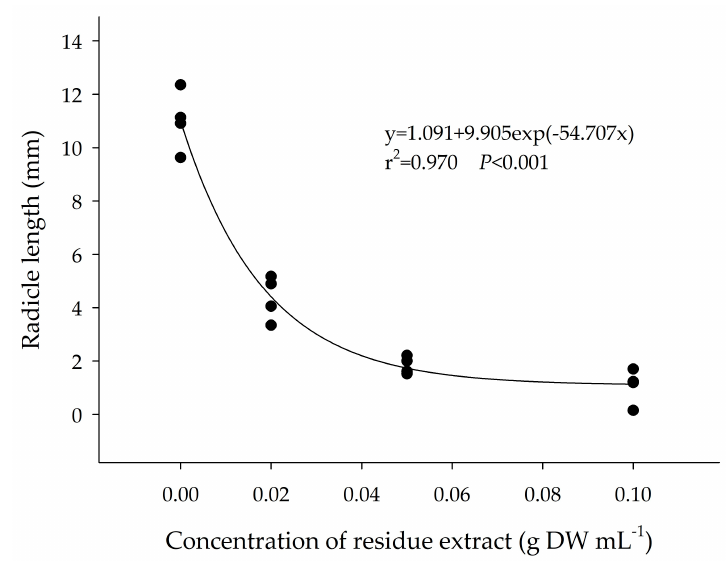
Figure 5. Relationship between the concentration of residue extract and the radicle length of Cobbler’s pegs seedlings.